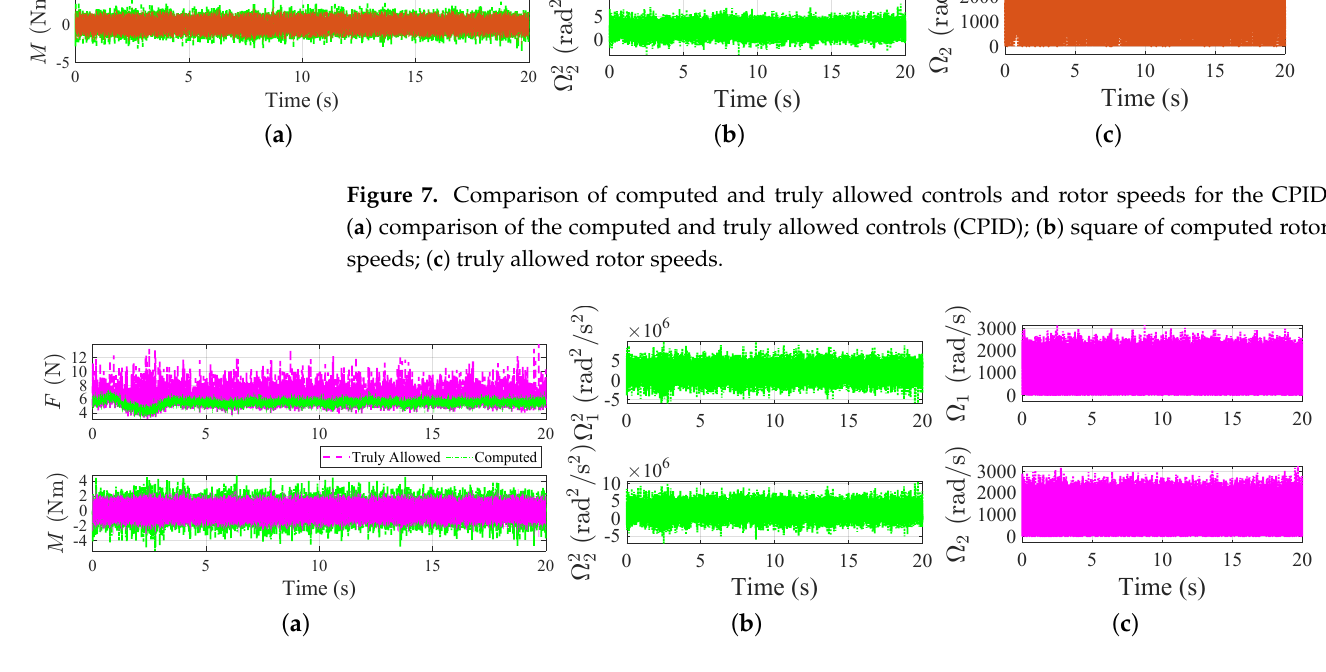
Figure 8. Comparison of computed and truly allowed controls and rotor speeds for the IBC. ( a ) comparison of the computed and truly allowed controls (IBC); ( b ) square of computed rotor speeds; ( c ) truly allowed rotor speeds.